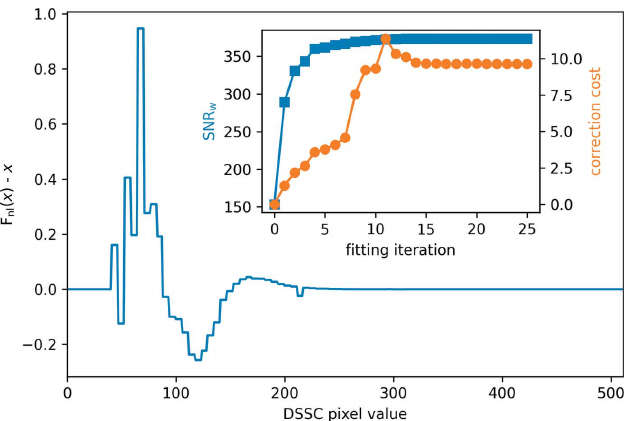
Figure 6 Fitted non-linear deviation from the ideal detector response F nl ( x ) (cid:2) x as a function of the DSSC pixel values. Inset: the evolution of the weighted SNR (blue squares) and the correction cost (orange circles) as a function of the fitting iteration